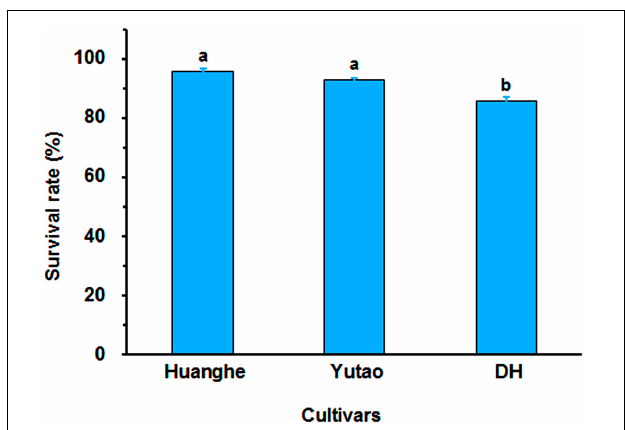
FIGURE 6 | The survival rate of “Huanghe,” “Yutao,” and “DH” plantlets after transplanting into soilless substrate grown in a shaded greenhouse. Bars represent standard error, and different letters on the top of bars indicate significant cultivar difference in survival rates analyzed by Duncan’s multiple range test at P < 0.05